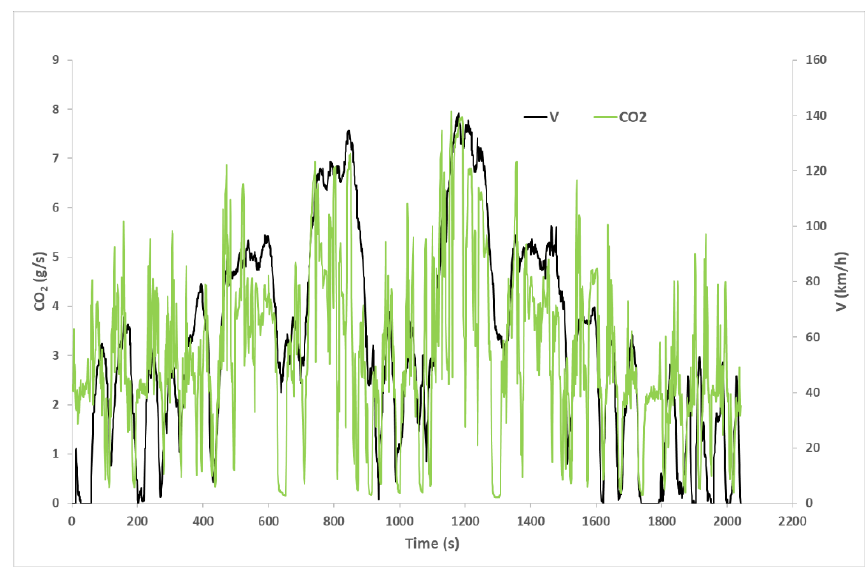
Figure 13. CO 2 emission versus vehicle speed in on-road test, CNG propulsion.